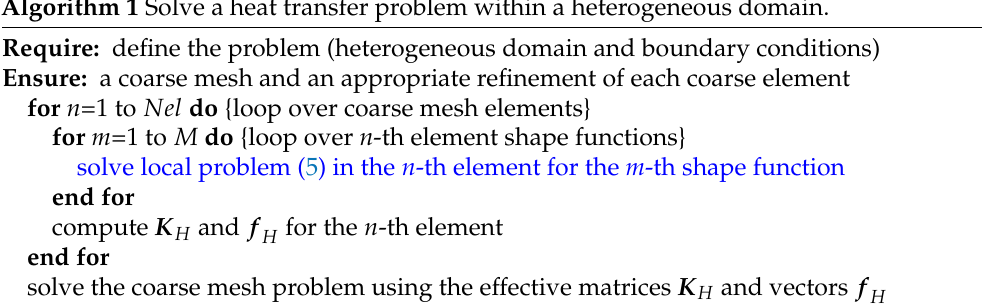
Algorithm 1 Solve a heat transfer problem within a heterogeneous